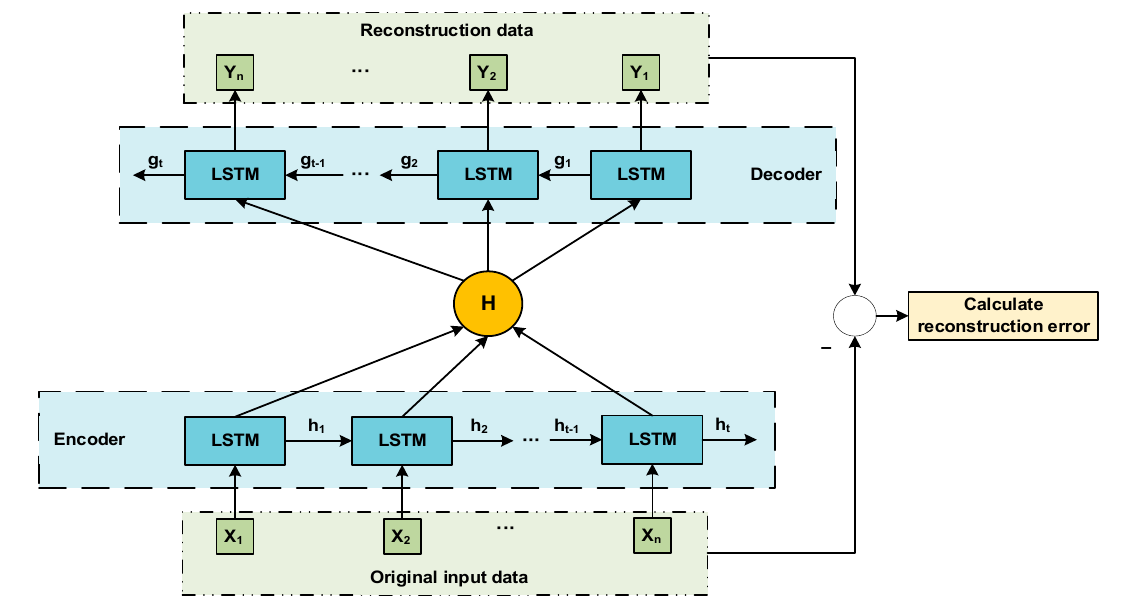
Figure 1. Prediction structure diagram of auto-encoder by LSTM.